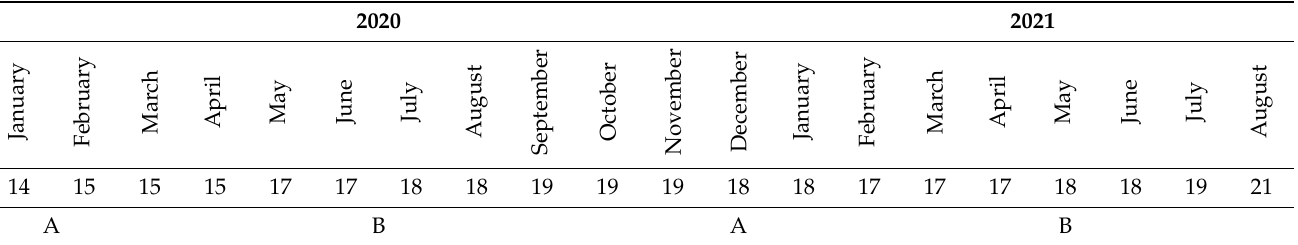
Table 1. Results of locomotion and social adaptability testing using the FIM test in a patient diagnosed with cerebral palsy diparesis; A—period of monthly testing with no intervention, B—period of intervention and monthly